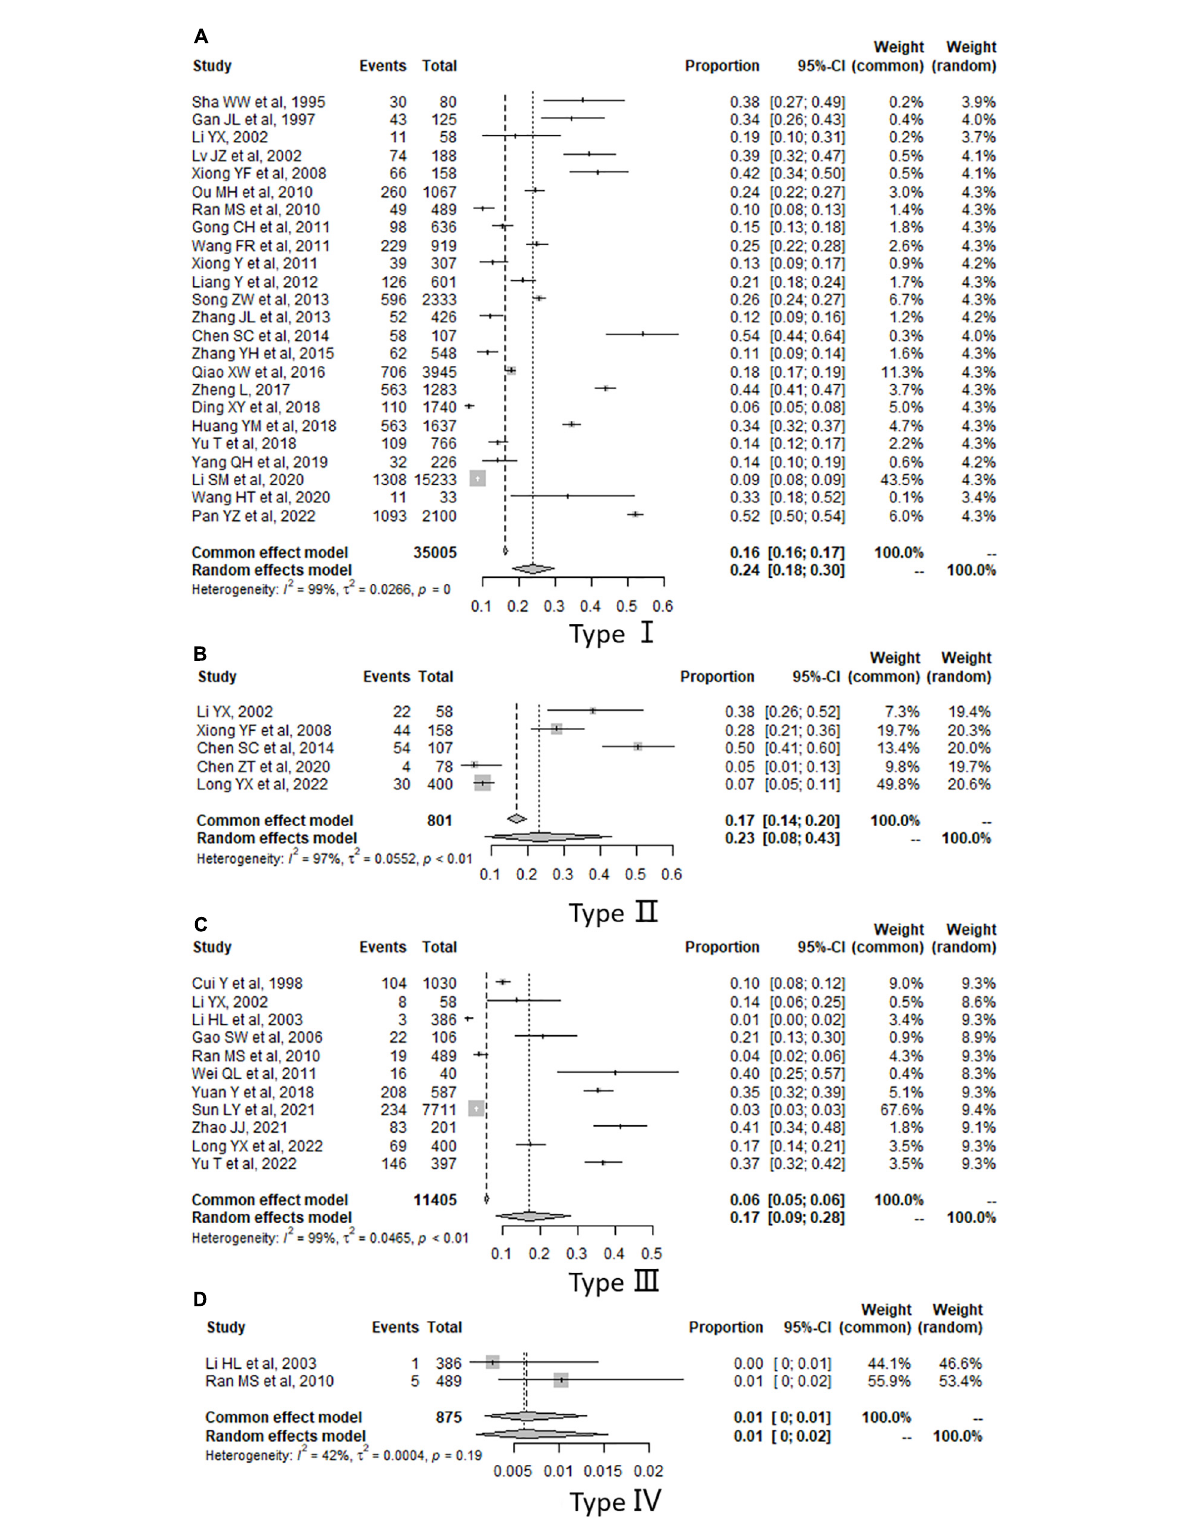
FIGURE2 Forest plot of the prevalence of violence. (A) Results of type I. (B) Results of type II. (C) Results of type III. (D) Results of type